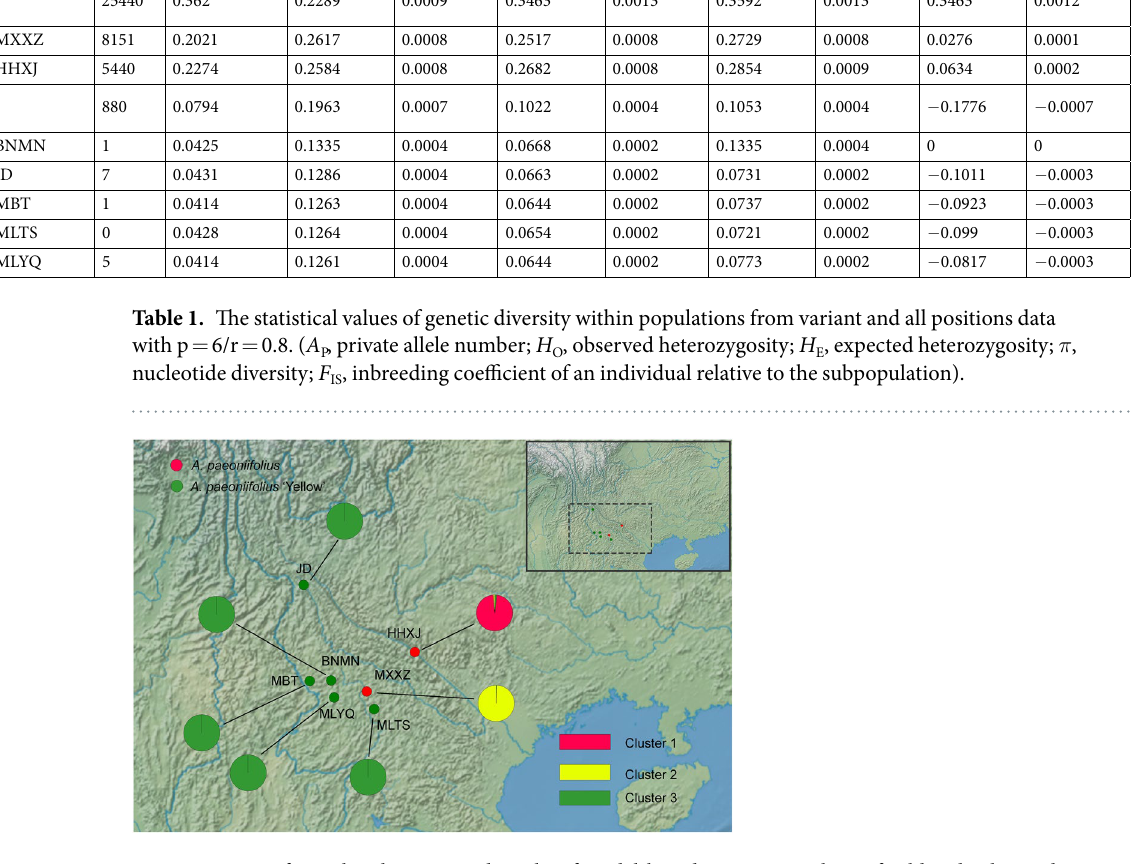
Figure 2. Map of sampling location and results of model-based structure analysis of wild and cultivated A. paeoniifolius populations. Individual pie charts indicate mean proportions of membership of each population for the inferred number of K = 3 genetic clusters. The map was created with free raster map data from Natural Earth